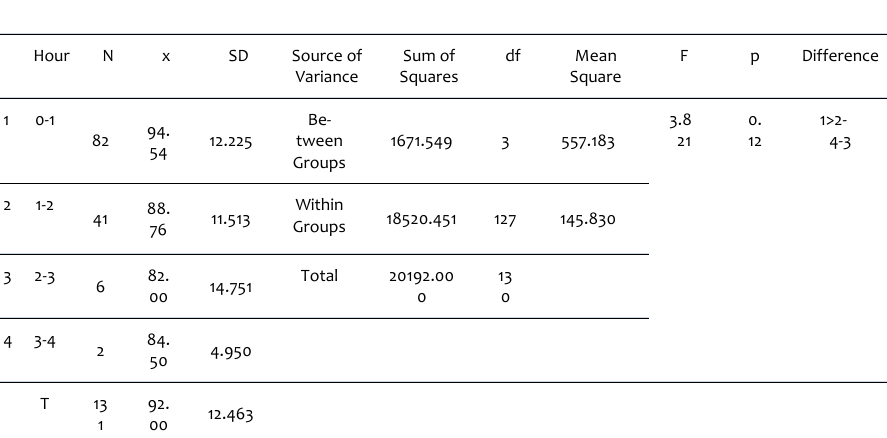
Table 12. Students' reading motivation scores in relation to hours of using